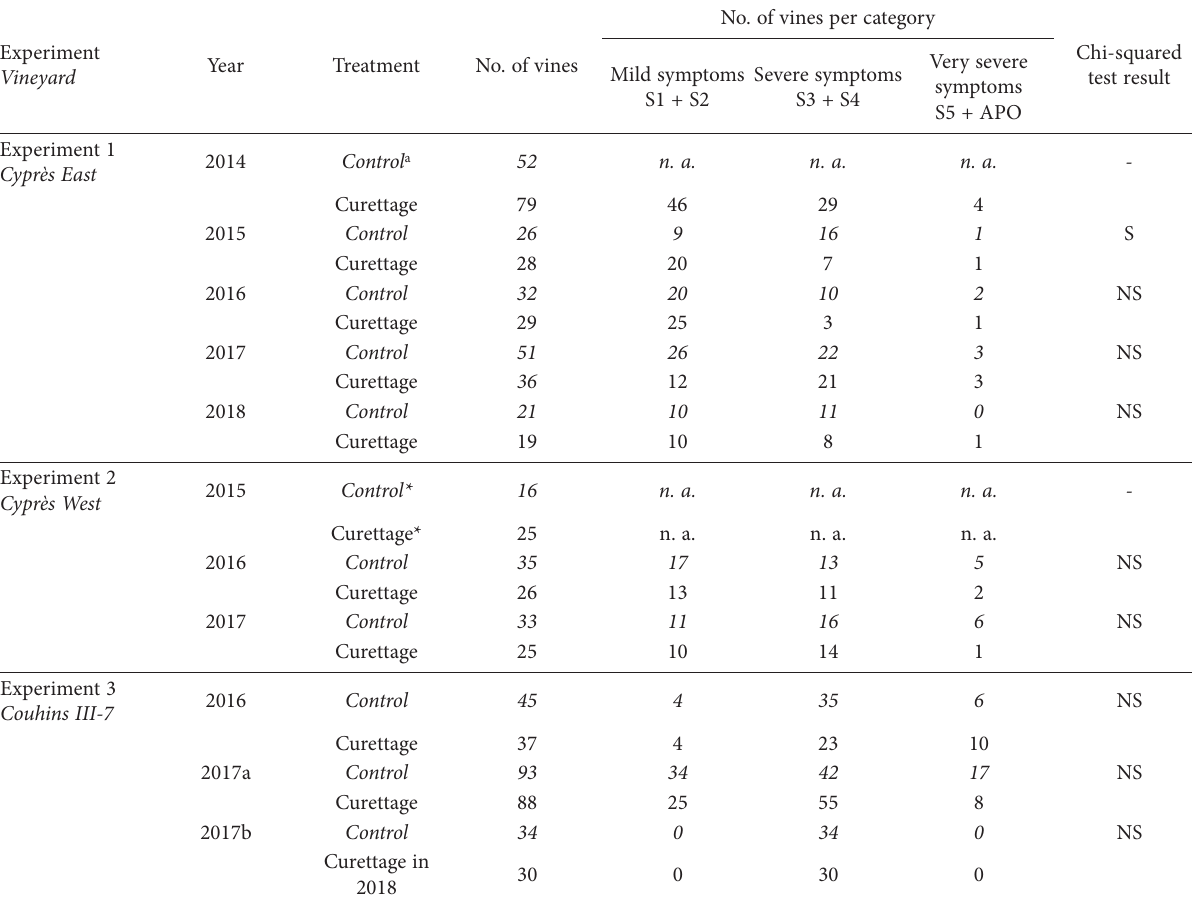
Table 3. Esca status of the control and curetted vines used in this study (11 trials). Distributions of vines between the three leaf symptom categories indicated in Table 2. The distributions were compared by pair-wise Chi-square tests ( P =